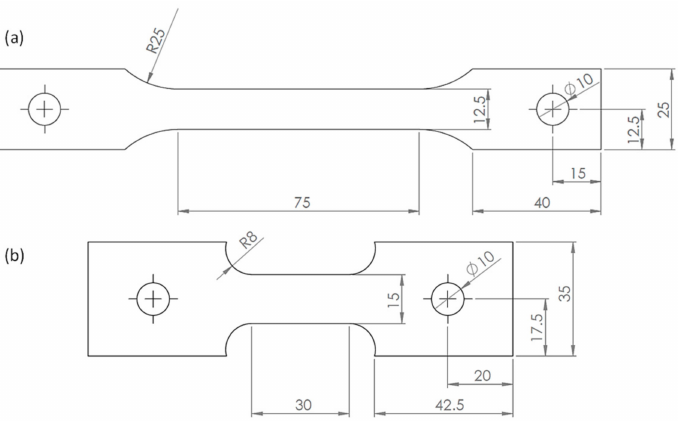
Figure 2. Test specimens used (dimensions in mm). ( a ) Tensile sample; ( b ) compression